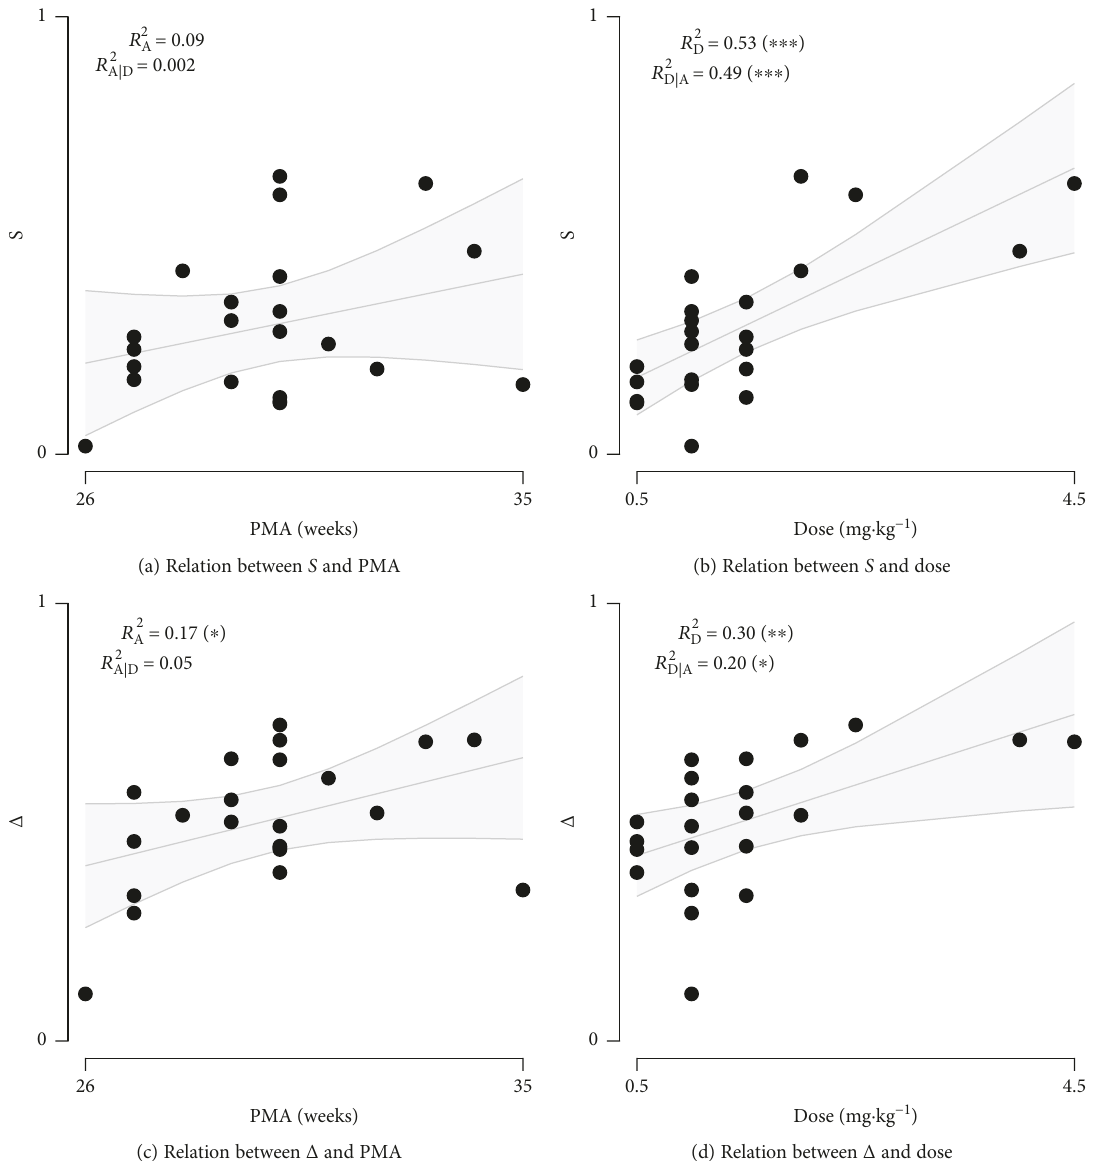
Figure 8: The relation between features S and Δ , computed from the MABP-EEG interaction curves presented in Figure 6, and PMA and propofol. The data points and the linear least squares fi t are depicted in black and gray, respectively. The shaded area indicates the 95-percentage con fi dence bounds on the least squares fi t. The coe ffi cient of (partial) determination is indicated in each plot (subscripts A and D denote PMA and propofol dose, resp.). A single asterisk, double asterisks, and triple asterisks denote a p value smaller than 0 . 05, 0 . 01, and 0 . 001,